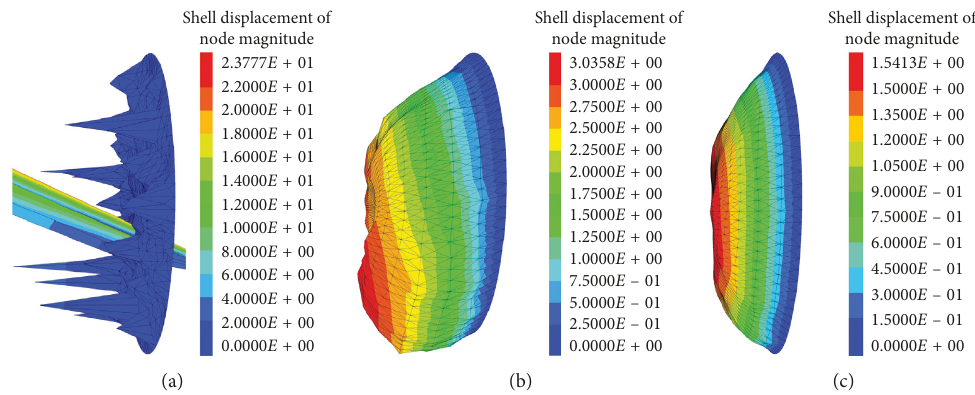
Figure 15: No support elastic modulus of shell (1 e 4, 1 e 5, and 1 e 6).